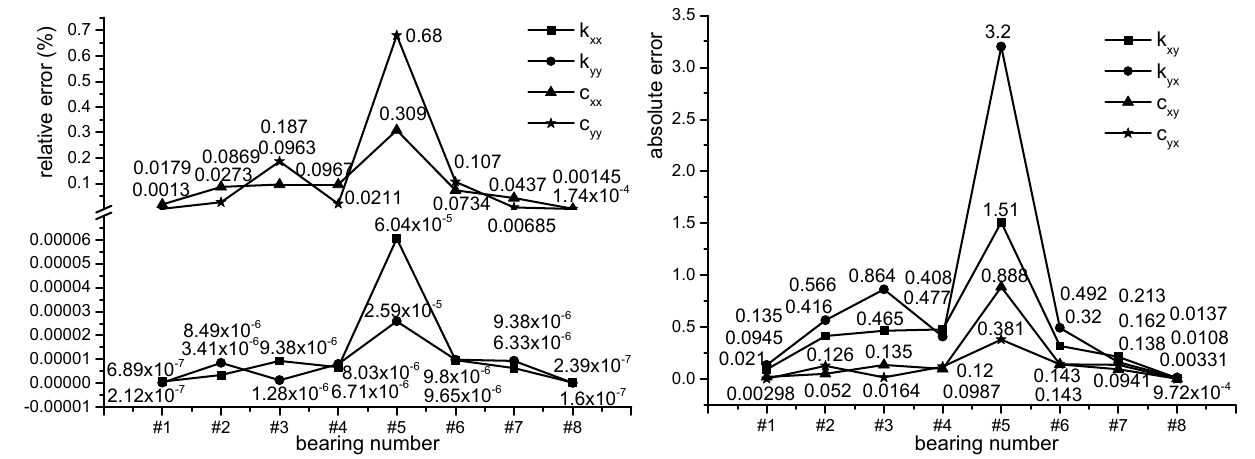
Figure 5. The biggest identification error obtained using g4.4 based Algorithm II. According to Figure 5, for the main coefficients, the maximum relative errors of k1.xx, k2.xx, . . . , k8.xx are almost equal to zero. They are only 6.89 × 10 − 7 %, 3.41 × 10 − 6 %, 9.38 × 10 − 6 %, 6.71 × 10 − 6 %, 6.04 × 10 − 5 %, 9.65 × 10 − 6 %, 6.33 × 10 − 6 % and 2.39 × 10 − 7 %, respectively. The maximum relative errors of c1.xx, c2.xx, . . . , c8.xx are bigger than that of the stiffness coefficients. They are 0.0179%, 0.0869%, 0.0963%, 0.0967%, 0.309%, 0.0734%, 0.0437% and 0.00145%, respectively, and are quite small. In the y direction, the maximum relative errors of k1.yy, k2.yy, . . . , k8.yy are only 2.12 × 10 − 7 %, 8.49 × 10 − 6 %, 1.28 × 10 − 6 %, 8.03 × 10 − 6 %, 2.59 × 10 − 5 %, 9.80 × 10 − 6 %, 9.38 × 10 − 6 % and 1.60 × 10 − 7 %, respectively. The maximum relative errors of the identified c1.yy, c2.yy, . . . , c8.yy, which are only 0.00130%, 0.0273%, 0.187%, 0.0211%, 0.680%, 0.107%, 0.00685% and 0.000174%, respectively, are also very small; though, they are bigger than that of the stiffness coefficients.